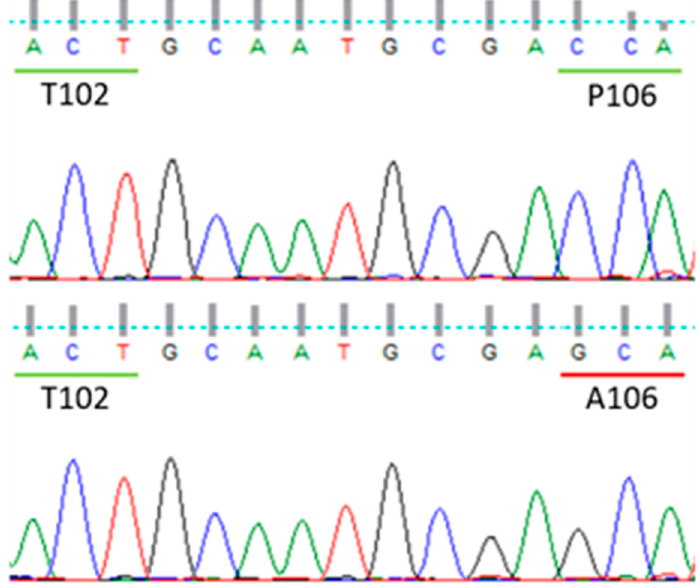
Figure 4. Screenshot of chromatograms obtained from a susceptible plant of 19-S biotype (upper graph) and a resistant plant of biotype 19-1 (bottom graph). Only codons from 102 to 106 are shown.